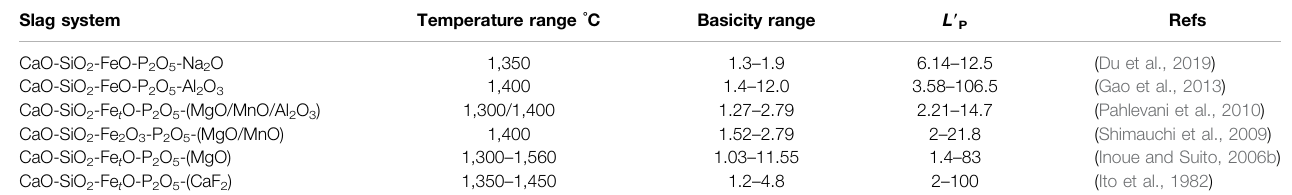
TABLE 2 | Studies on the distribution ratio of P 2 O 5 between solid solution and liquid phase in multi-phase slag Slag system